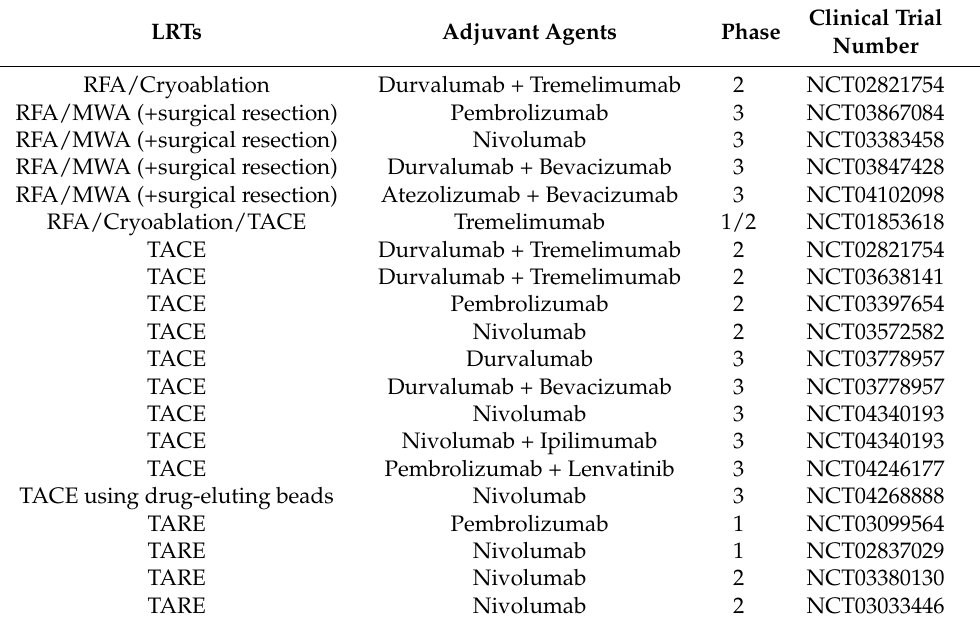
Table 1. Clinical trials of adjuvant immune checkpoint blockades following locoregional treatments for